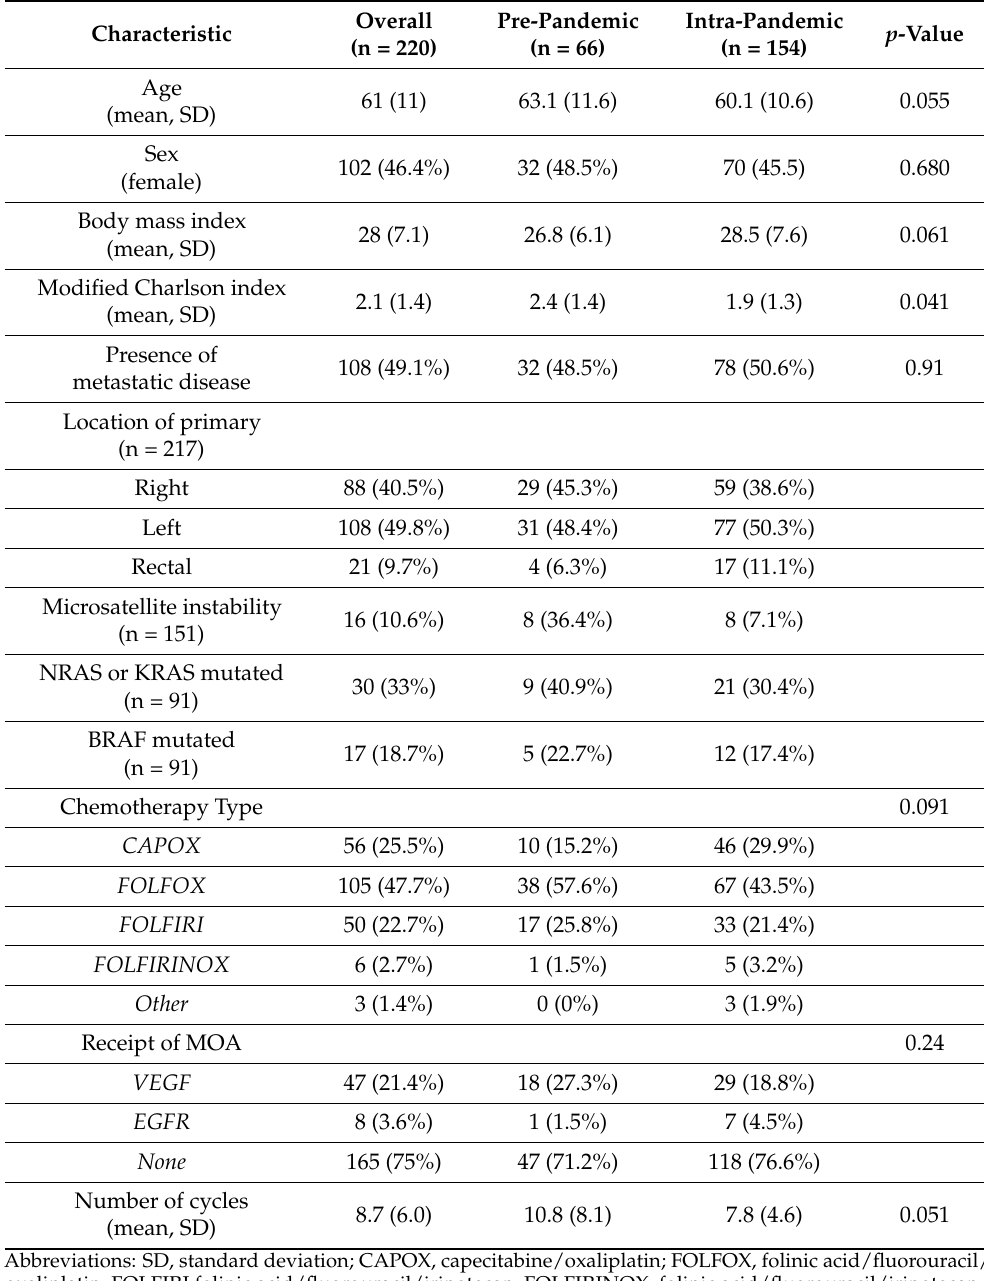
Table 1. Baseline characteristics of study